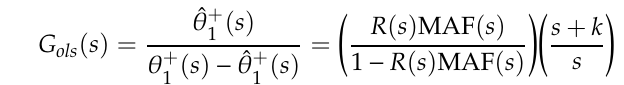
Figure 13. Simplified model of the proposed PLL.